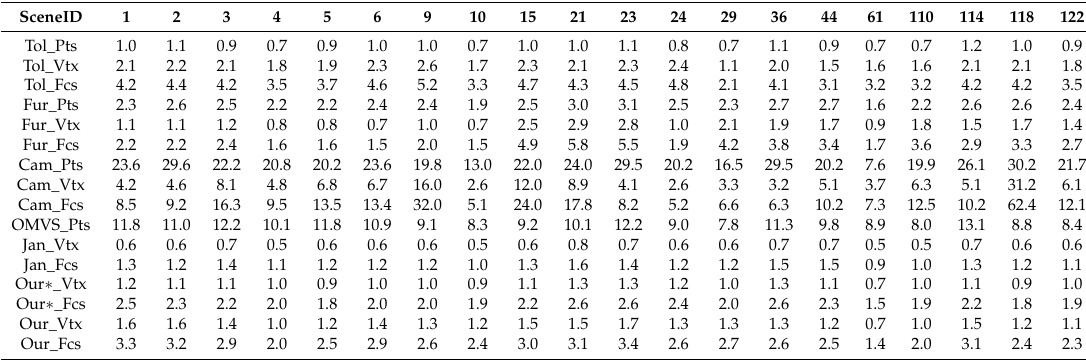
Figure 13. Result of the proposed method on four scenes of the training set of Tanks and Temples dataset [40]. From left to right are: ( a ) the input images; ( b ) the precision of the model generated by the proposed method; ( c ) the recall of the model generated by the proposed method; and ( d ) the evaluation result (higher is better) of the models generated by Colmap [38] and three other methods depicted in Figure 10. Table 2. Information of the 3D models evaluated on MVS dataset [2]. ∗ _Pts is the number of points in a 3D point cloud. ∗ _Vtx and ∗ _Fcs are the number of vertices and facets of a 3D mesh, respectively. The unit of all numbers is million.